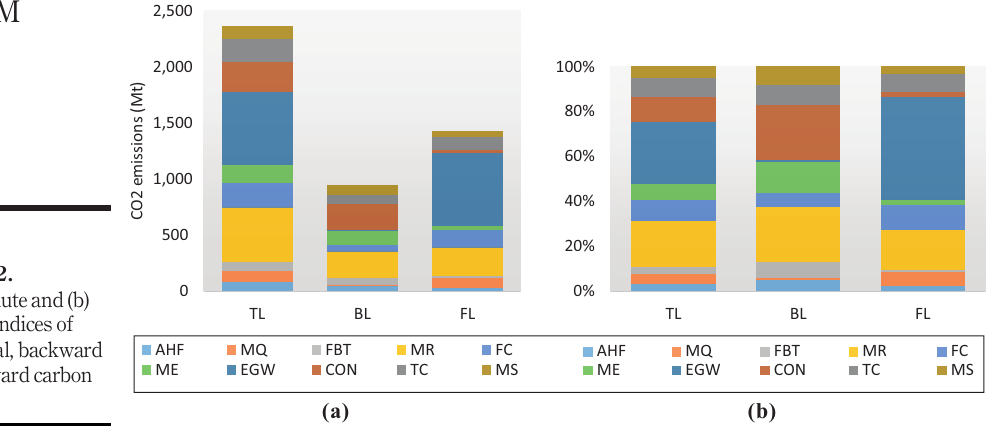
Figure 2. (a) Absolute and (b) relative indices of Cella total, backward and forward carbon linkages